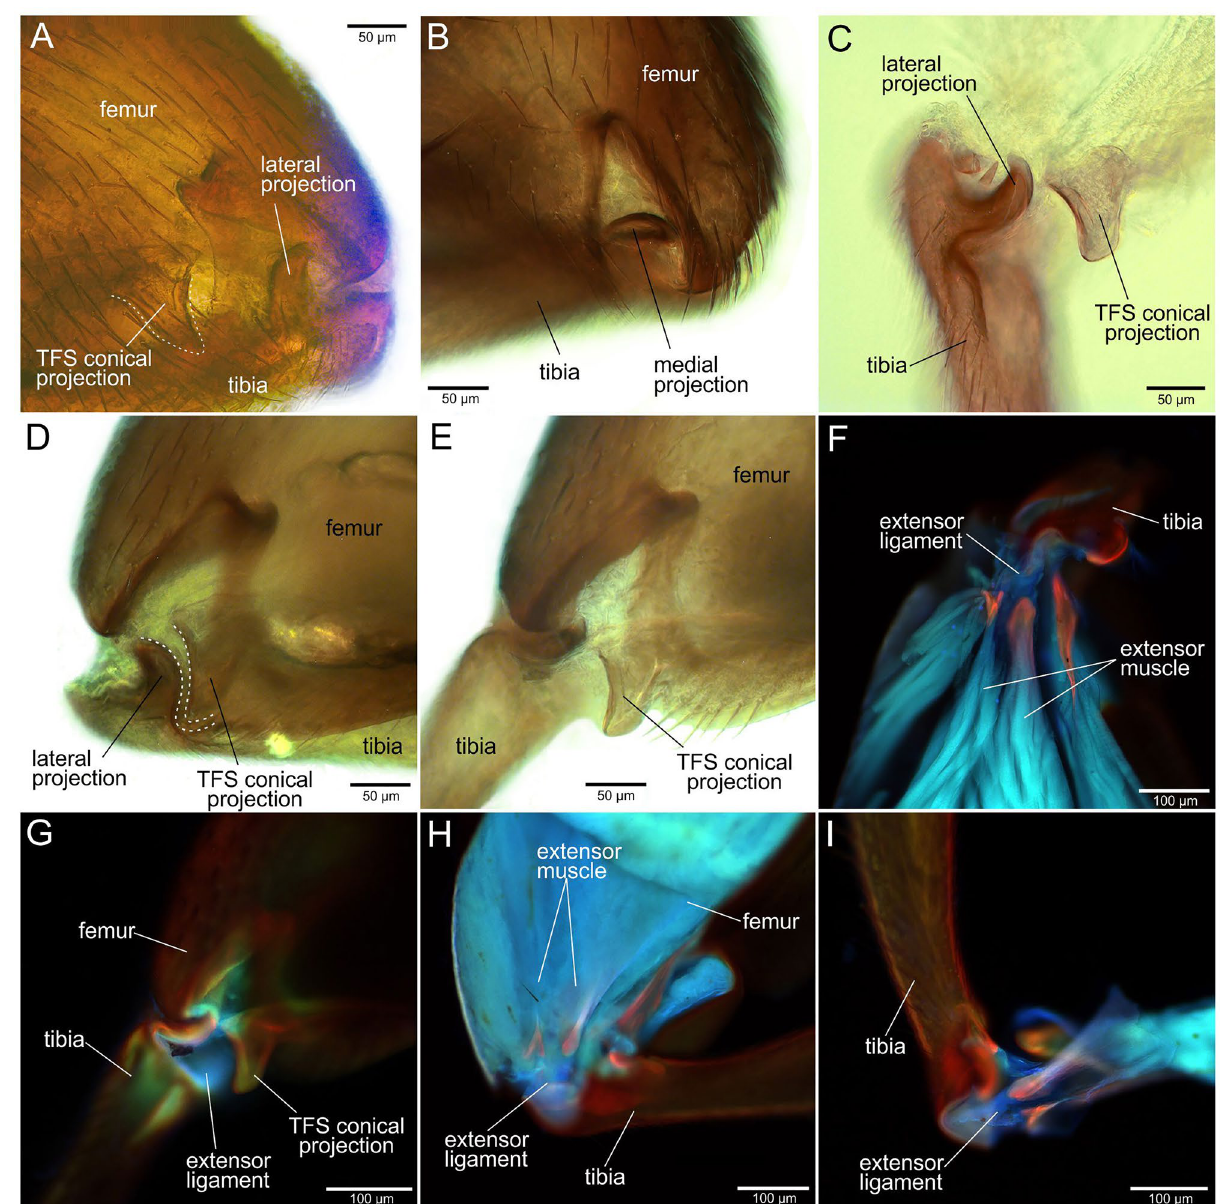
Figure 4. Femoro-tibial joint of the hind jumping leg of Scirtes hemisphaericus , light microscopy ( A – E ) and confocal laser scanning microscopy (CLSM) ( F – I ). Resilin-bearing extensor ligament is bright blue or purple- blue. ( A ) Femoro-tibial joint with flexed tibia showing the position of lateral projection, external view, lateral side. ( B ) Femoro-tibial joint with flexed tibia showing the position of medial projection, external view, medial side. ( C ) Tibial base and tibial flexor sclerite with the conical projection of tibial flexor sclerite (TFS). ( D ) Femoro-tibial joint with the flexed tibia, TFS conical projection inserted into the socket of tibial base and is in locked position. TFS conical projection and corresponding socket on tibia are outlined by white dashed line. ( E ) Femoro-tibial joint with extended tibia, external view; TFS conical projection is outside of the corresponded socket of tibial base and is in unlocked position. ( F ) Tibial base and muscles connected by the extensor ligament, lateral view. ( G ) Femoro-tibial joint externally, lateral view. ( H ) Sagittal section of the femur. I, Tibial base with extensor ligament, lateral view. TFS tibial flexor